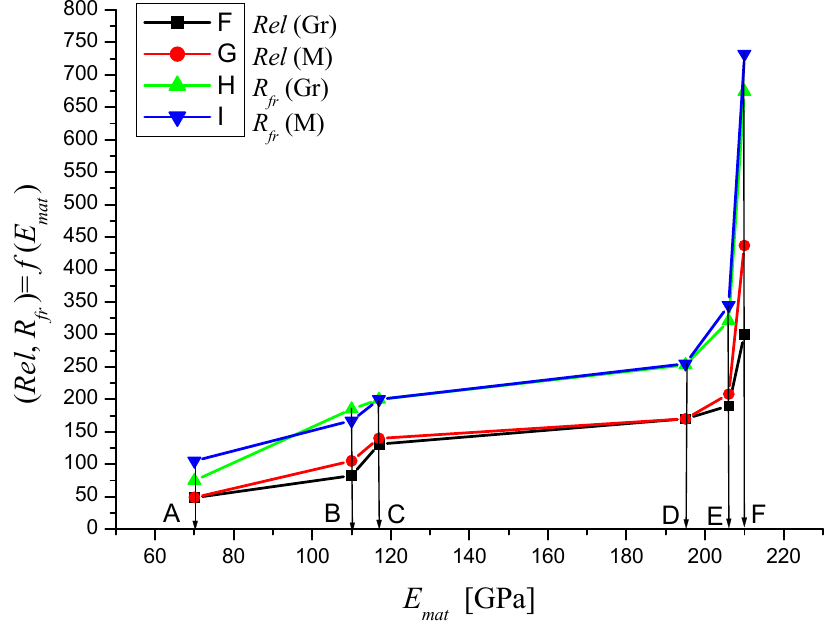
Figure 16. Dependencies of material parameters (Mes) and theoretical (Gr) for materials A—aluminium, B—titanium, C—commercially pure copper, D—AISI 304, E—commercially pure iron, F—AISI 309.